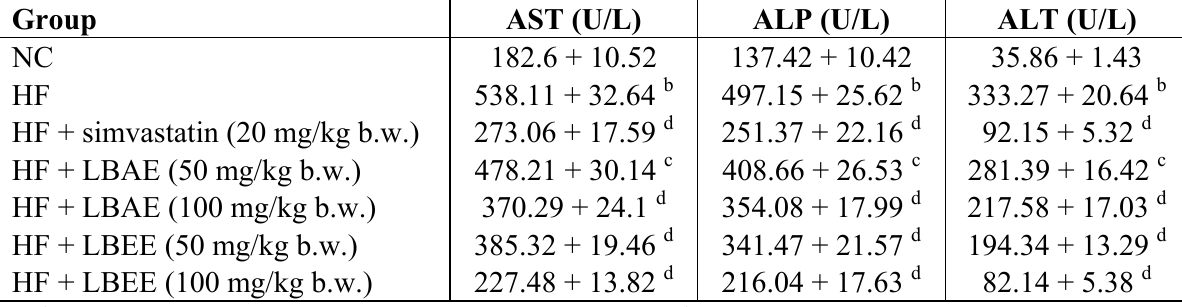
Table 3. Effect of LBAE and LBEE on serum AST, ALP, ALT activities in rats.